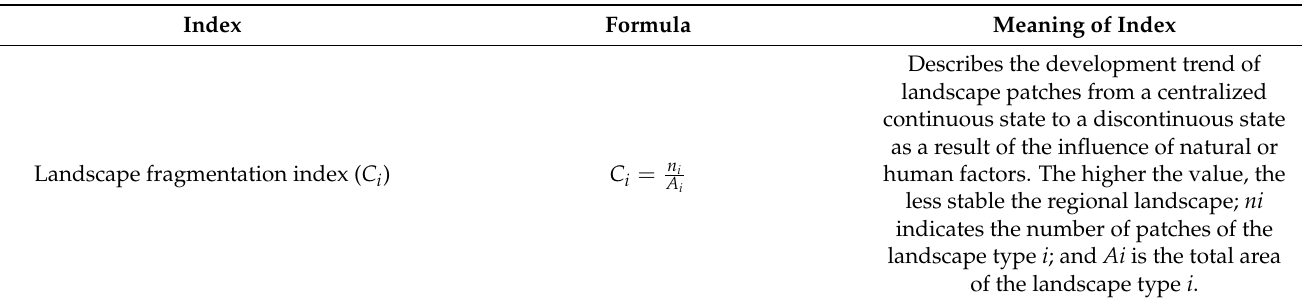
Table 1. Formula and meaning of the Landscape index